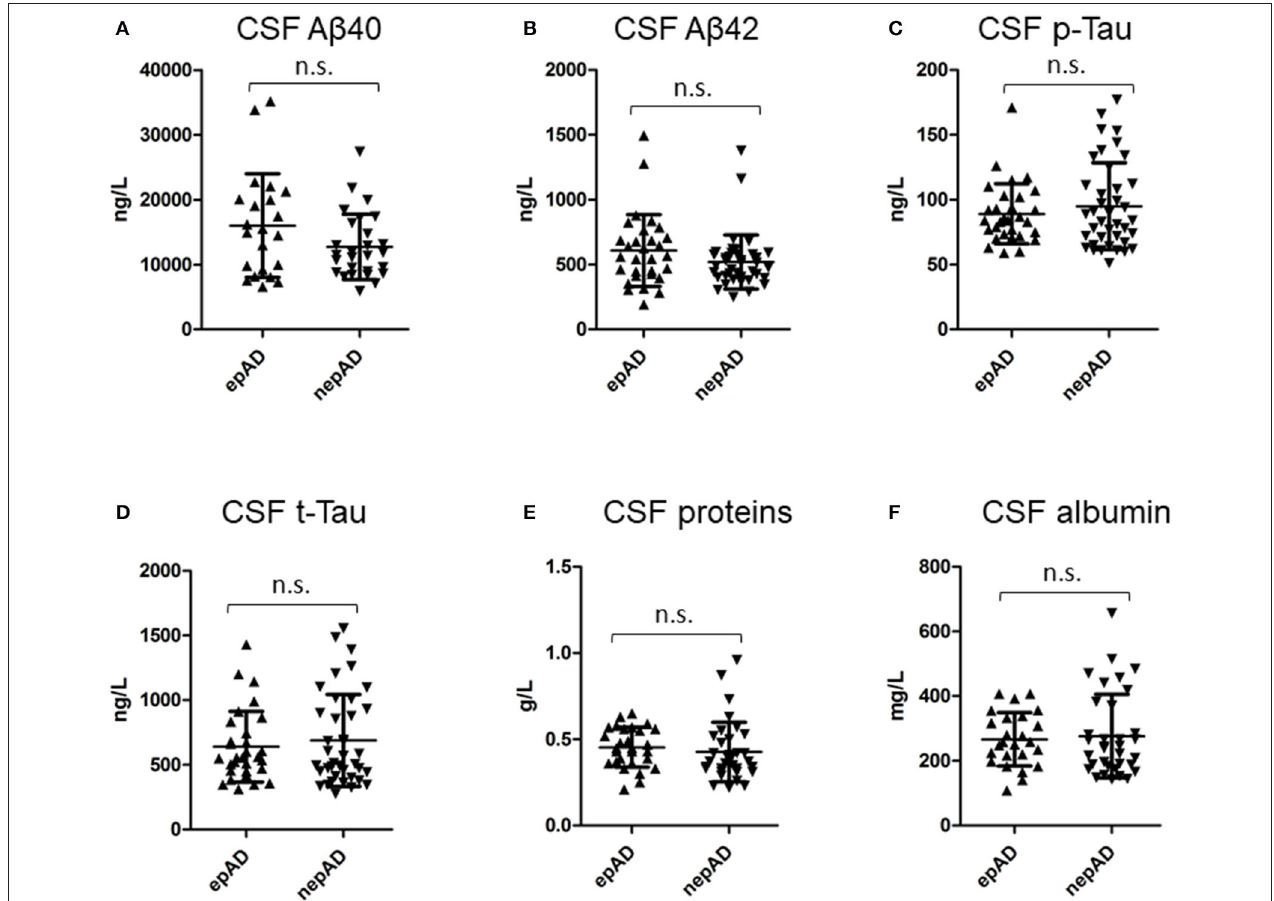
FIGURE 2 | CSF compounds in epADs and